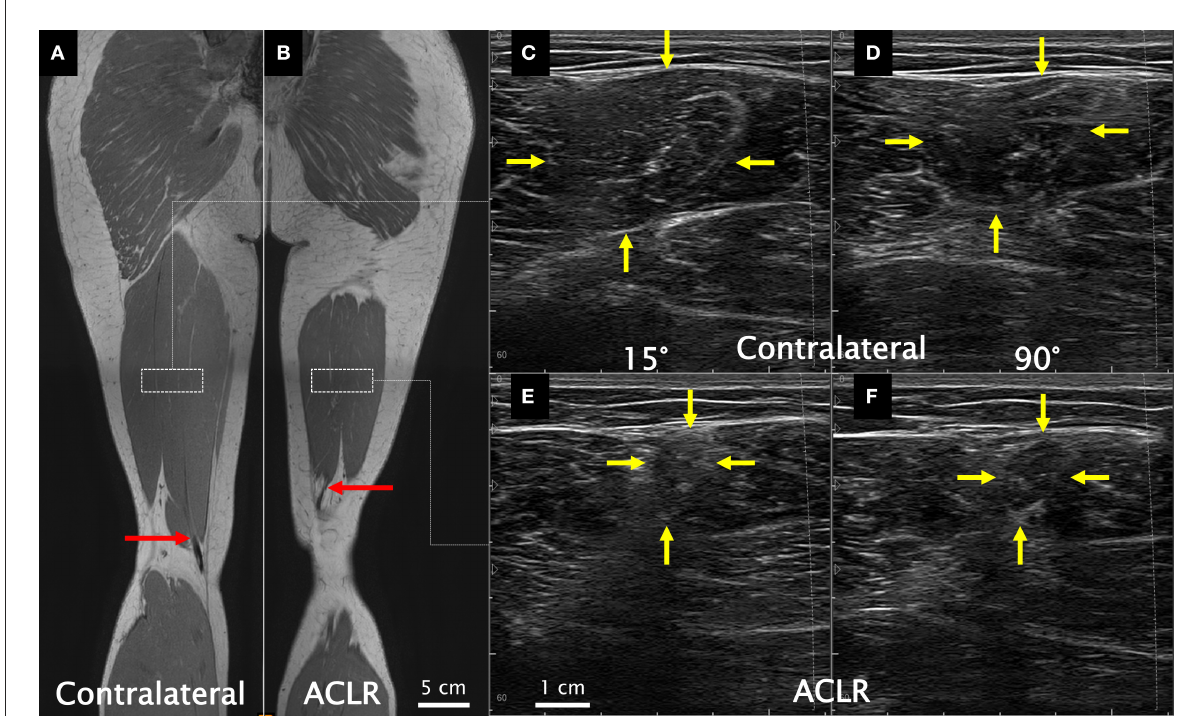
FIGURE1 Coronal view from the in-phase sequence of a T 1 Dixon magnetic resonance image (MRI) series acquired supine (used here only for illustrative purposes) of the contralateral (A) and the anterior cruciate ligament reconstructed (ACLR) (B) legs. Red arrows illustrate the end of the muscle–tendon junction (beginning of the free tendon), which was quantitatively assessed from ultrasound. Dashed white rectangles approximate the recommended proximodistal electrode placement according to SENIAM guidelines. Resting ultrasound images of the contralateral leg at 15 ◦ (C) and 90 ◦ (D) of knee joint flexion and of the ACLR leg at 15 ◦ (E) and 90 ◦ (F) of knee joint flexion. Yellow arrows indicate the semitendinosus muscle borders. Note that the MRI images are not from the same coronal slice for both legs and do not capture the full length of the semitendinosus muscle within a given slice (slices for this figure were chosen independently for each leg to best visualize the distal semitendinosus muscle–tendon junction). Also note that the ultrasound images were acquired so all images contained the same left-to-right orientation. All images are from the same